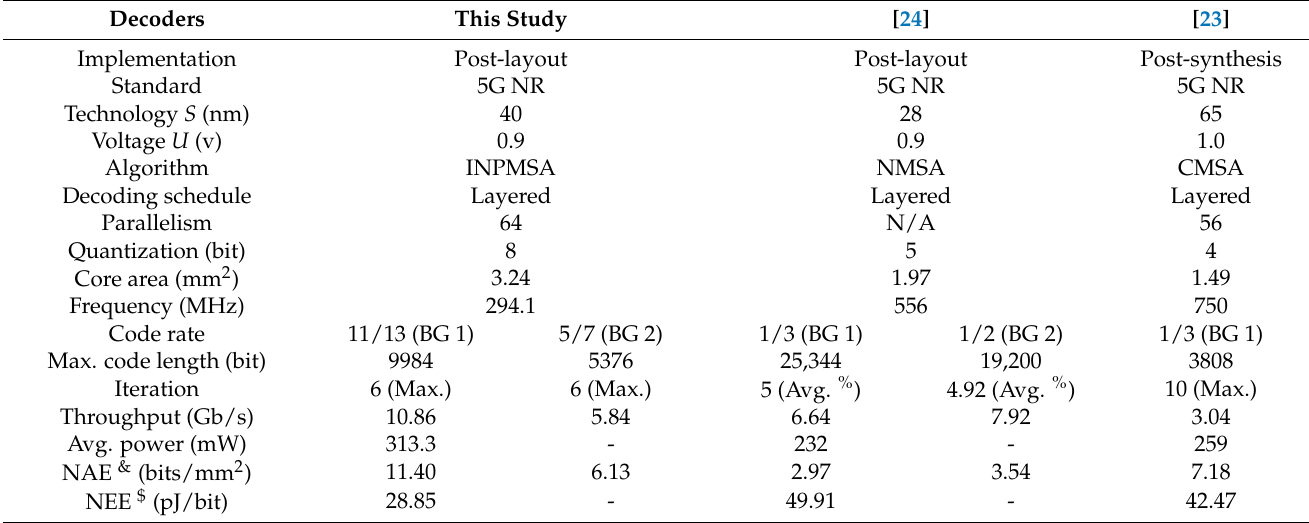
Table 3. Chip comparison of QC-LDPC decoder ASICs for 5G NR